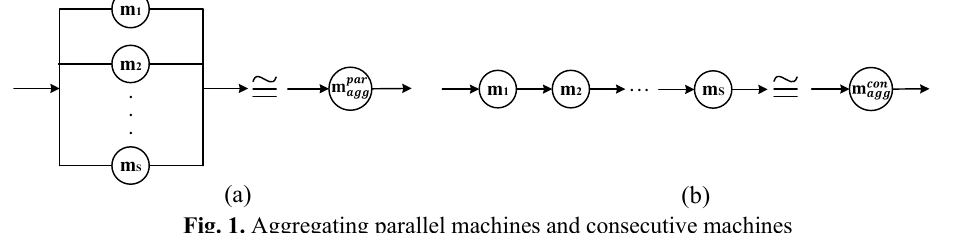
Fig. 1. Aggregating parallel machines and consecutive